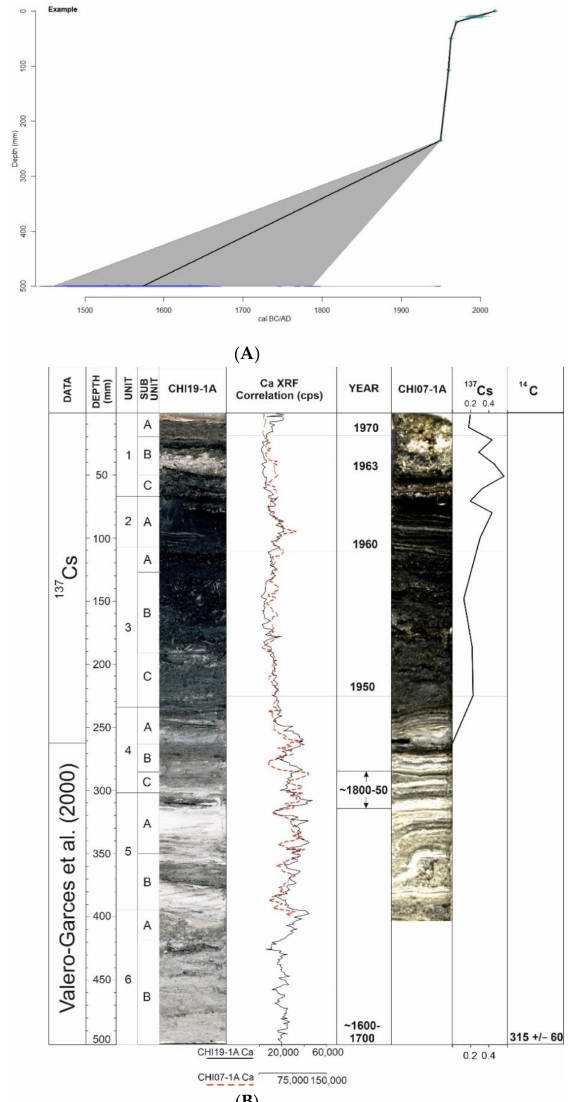
Figure 2. ( A ) Clam [47] generated age-depth model for the last ~350–400 years of Lake Chiprana based on 210 Pb, 137 Cs and 14 C dates. Chronological model modified from [30]. ( B ) Chronological correlation between core CHI19-1A and a core (CHI07-1A) retrieved from Lake Chiprana in 2007, provided by IPE. Adapted from [30], see this study for further